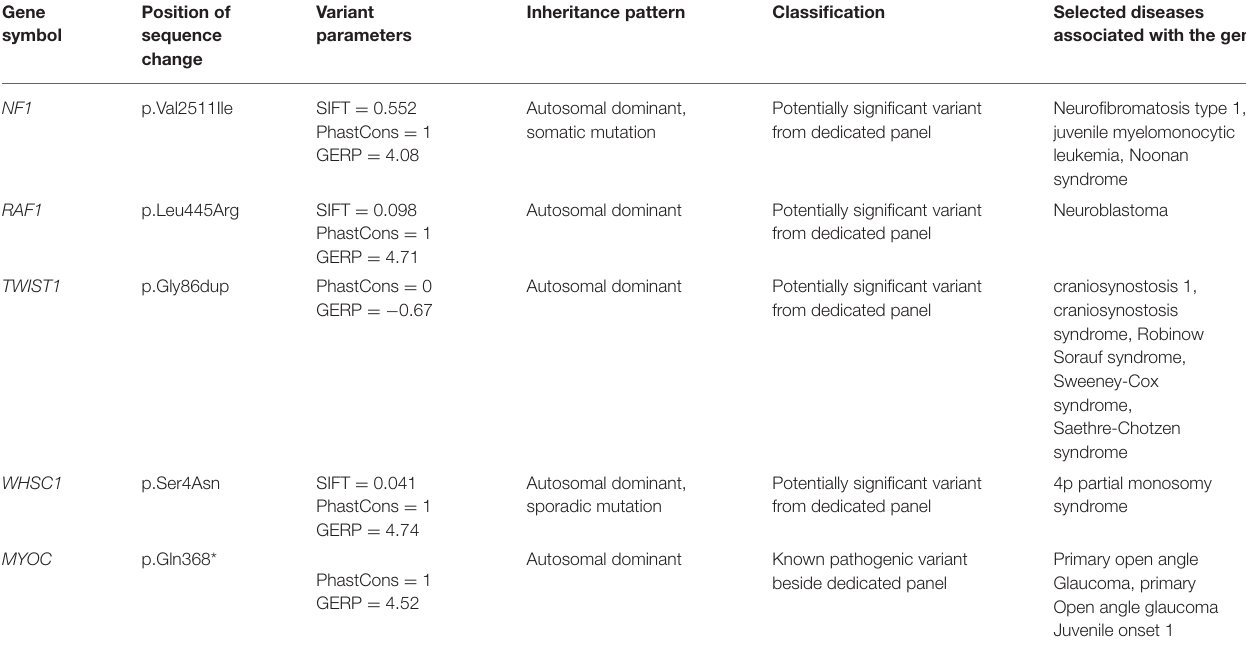
TABLE 1 | Selected potentially significant pathogenic genetic variants detected in the patient. Gene